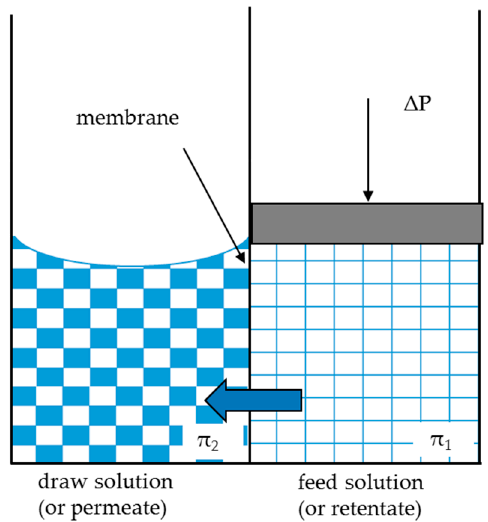
Figure 1. Pressure-driven membrane processes and osmotically driven membrane processes. For the pressure-driven membrane process, water migrates from retentate to permeate under applied pressure ∆ P . For the osmotically driven membrane process, water migrates from the feed solution to the draw solution under osmotic pressure difference π 1 − π 2 .